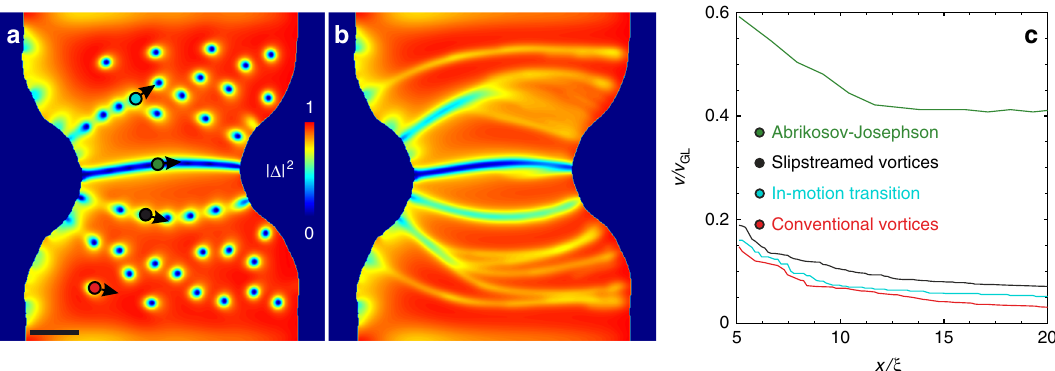
Fig. 6 Different morphologies of ultra-fast vortices at velocities signi fi cantly higher than in our experiment. a , b A snapshot a and time-averaged Cooper- pair density Δ 2 ( x , y ) b as in Fig. 5, but for twice higher applied fi eld and twice the current. Three vortex phases are found with distinctly different core structure, level of quasiparticle tailgating, velocities and resulting kinematic trajectories (see text and Supplementary Movies 7 and 8), namely the extremely fast Abrikosov-Josephson vortices (marked by green dot ), the ultrafast slipstreamed vortices ( black dot ), and conventional Abrikosov moving vortices ( red dot ). c Spatial pro fi les of vortex velocities v ( x ) (scaled to v GL = ξ / τ GL , see Methods) for the three main vortex phases, and for one detected branch of vortices going through an in-motion transition (dynamic transition from slipstreamed vortices to conventional Abrikosov vortices, identi fi ed by a blue dot in a ). The scale bar in a is 20